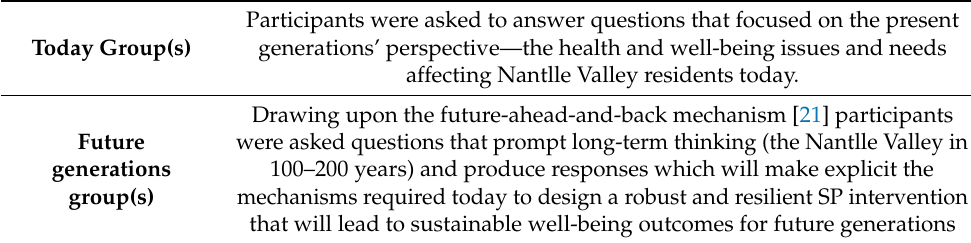
Table 2. Focus group titles and their meanings.